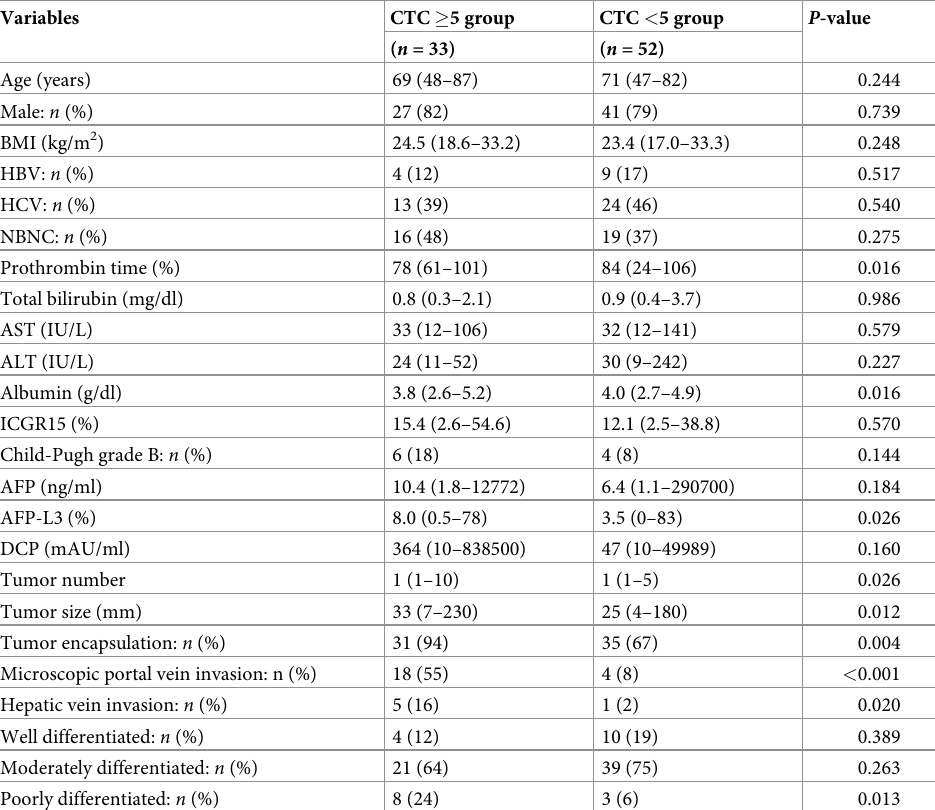
Table 2. Clinicopathologic features between CTC � 5 and < 5 group.